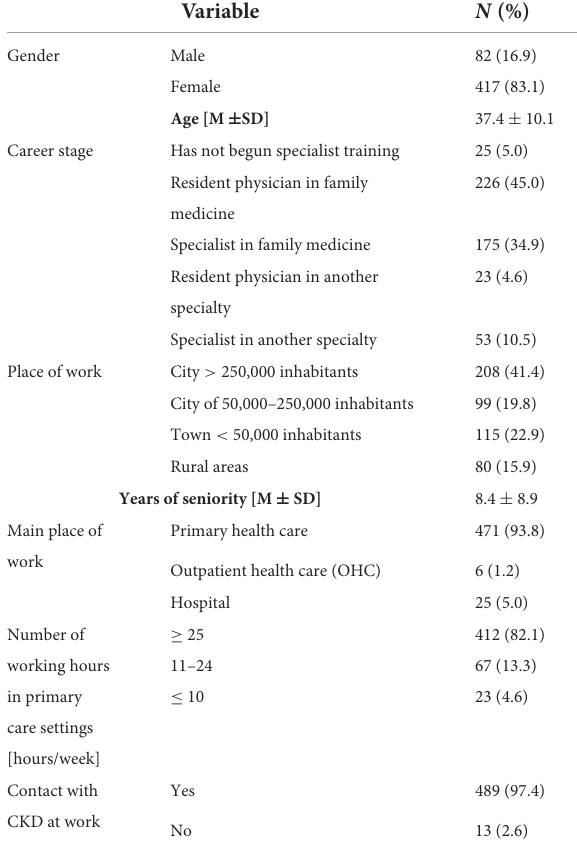
TABLE 1 Characteristics of the study